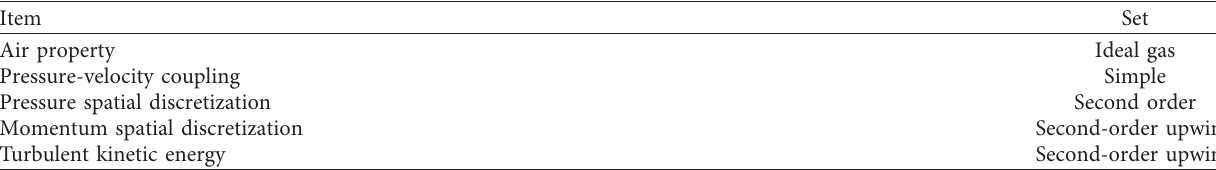
Table 3: Set of steady parameters.